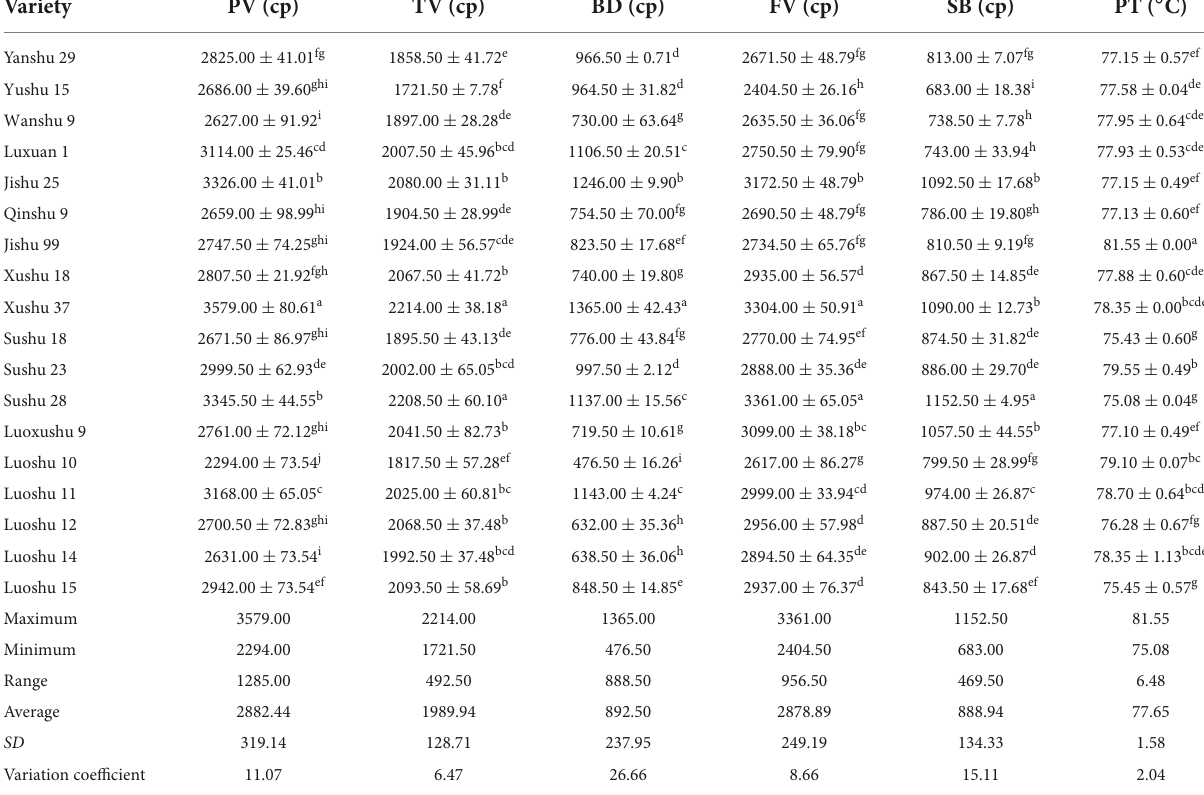
TABLE 3 The pasting parameters of sweet potato